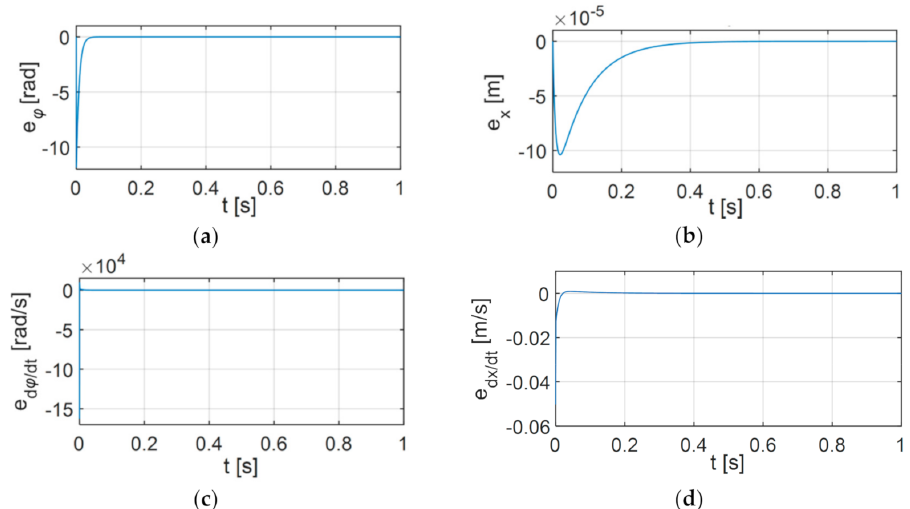
Figure 11. Follow-up movement errors: ( a ) position error of the active part e ϕ ; ( b ) position error of the passive part e x ; ( c ) speed error of the active par e d ϕ / dt ; ( d ) speed error of the passive part e dx / dt .